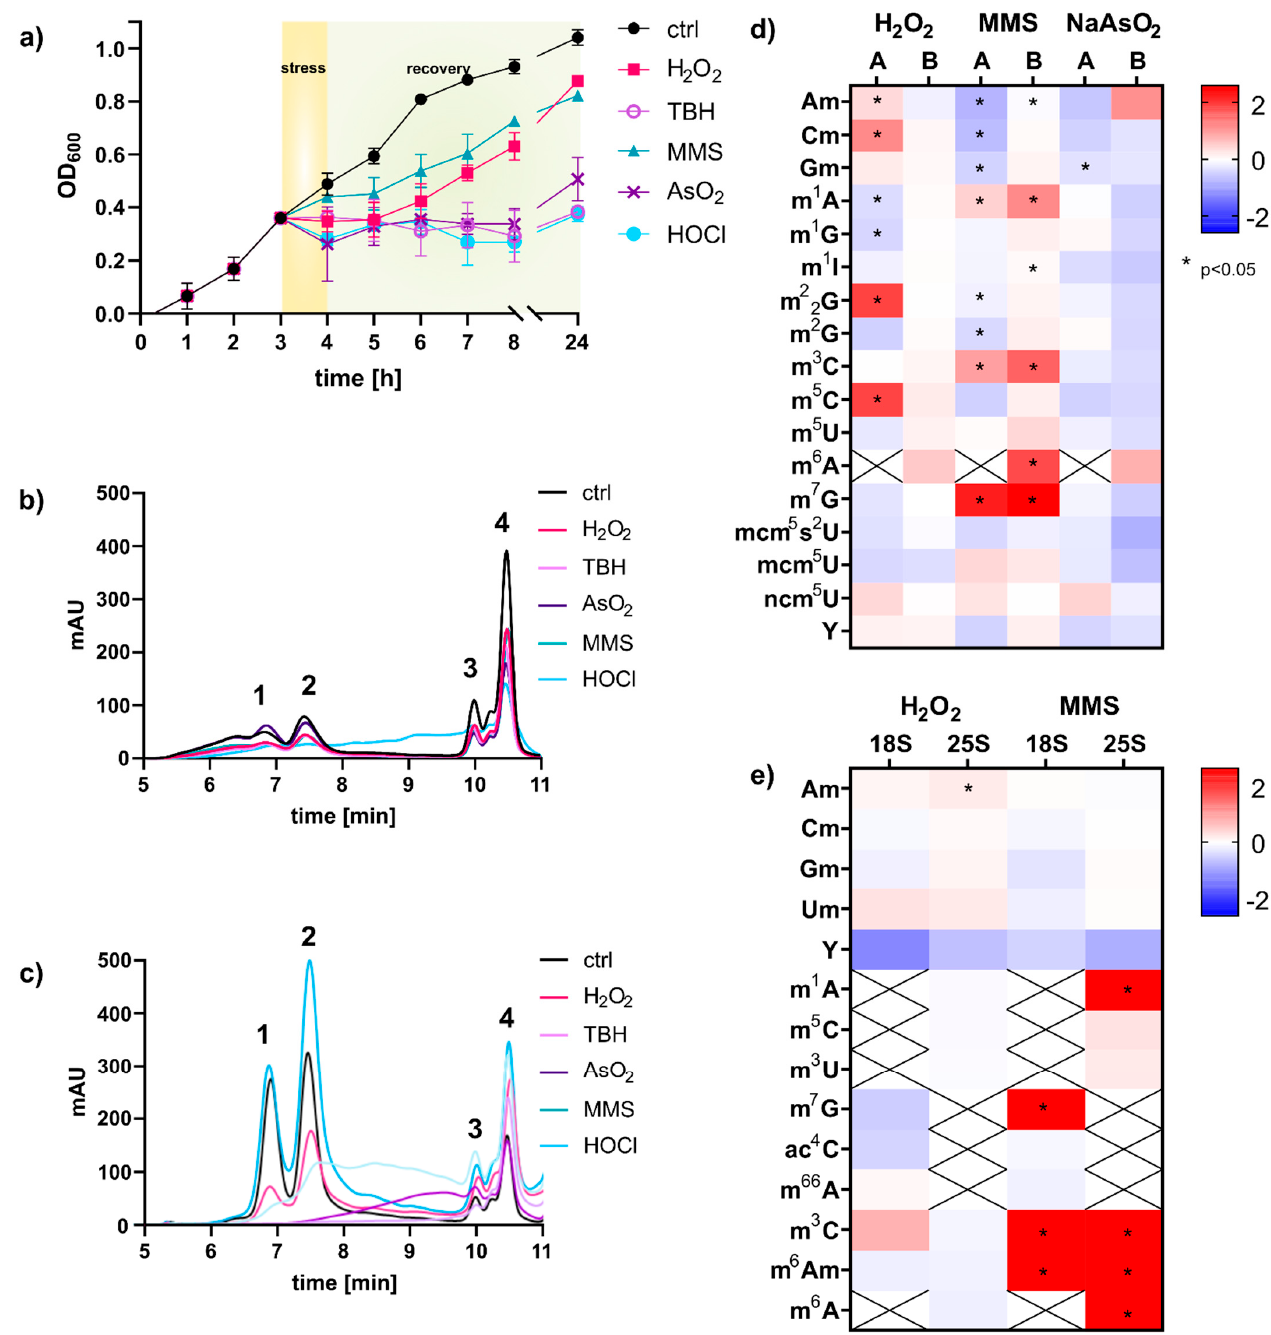
Figure 1. Analysis of total RNA and RNA modification changes upon chemical stress exposure of S. cerevisiae cultures . ( a ) Logarithmic growth curve in YNB medium using LD 50 concentrations of stressors: H 2 O 2 (2 mM), NaAsO 2 (40 mM), HOCl (3 mM), MMS (12 mM), TBH (10 mM). ( b ) Total RNA of S. cerevisiae isolated with TRI reagent or hot phenol ( c ) assessed with size exclusion chromatography, 1: 25S, 2: 18S, 3: 5.8S rRNA, 4: tRNA ( d ) Fold changes in modification density in small RNA < 200 nts: (A) Chan et al . and (B) total tRNA from this work. An increase is shown in red and a decrease in blue. Student’s t-test results: p < 0.05 indicated with *. ( e ) Fold changes in modification density in 18S and 25S rRNA; Student’s t-test results: p < 0.05 indicated with *. All experiments were done in biological triplicates; error bars reflect standard deviations.